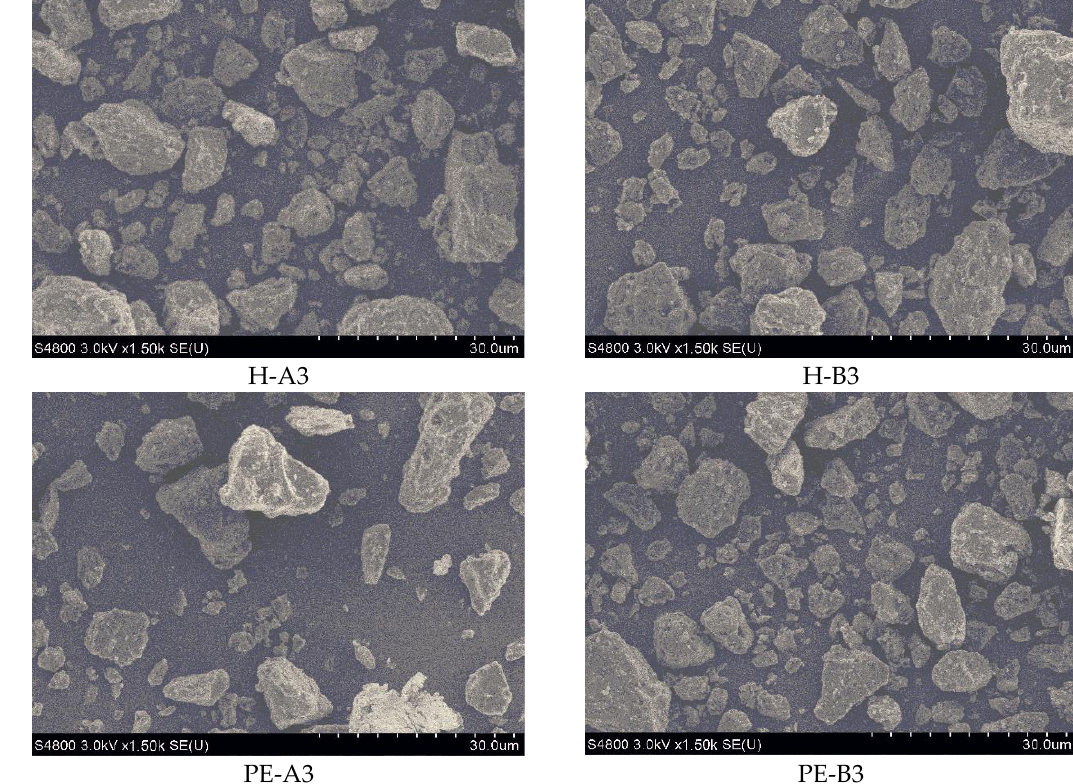
Figure 5. SEM micrographs of powder paints.